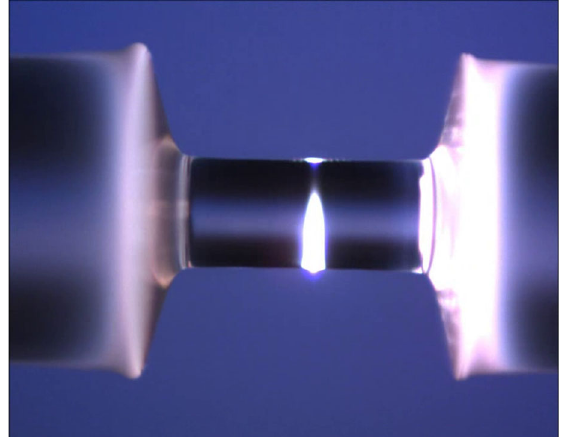
followed by resonator fabrication. The laser beam is scanned along the axis of the rod for continuous material removal. This procedure enables wide control over the diameter of microrod resonators. Commentary during the video provides